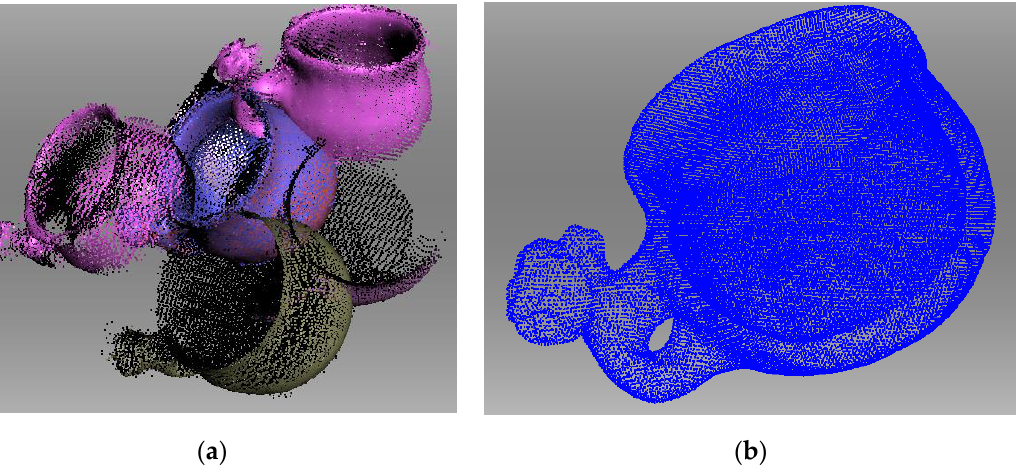
Figure 5. View: ( a ) single scans in local coordinate systems; ( b ) scans in the global coordinate system.